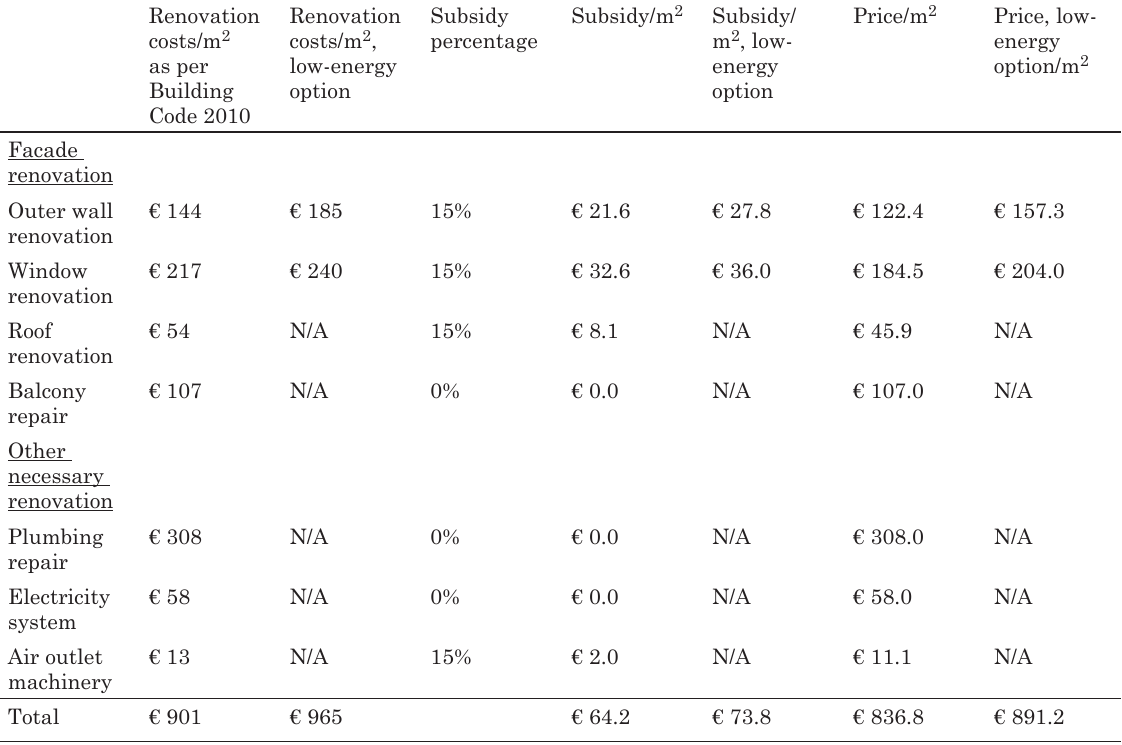
table 2. estimated refurbishment costs in Siltamäki (after: lantto and Saari, 2010; lahti,